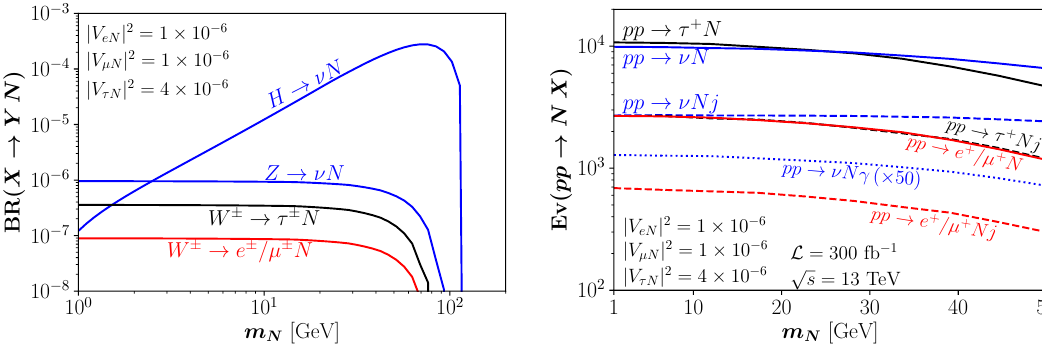
Figure 4 . Left: branching ratios for W (cid:6) ‘ (cid:6) N , Z (cid:23)N and H (cid:23)N , where (cid:23) stands for ! ! ! the sum over the three light neutrinos. Right: HNL production at LHC in association with a charged lepton or a light neutrino. We also show the production with an additional jet or photon 2 = 2 = 10 (cid:0) 6 with p j > 20 GeV and p (cid:13) > 10 GeV, respectively. We have chosen V eN V (cid:22)N T T j j j j